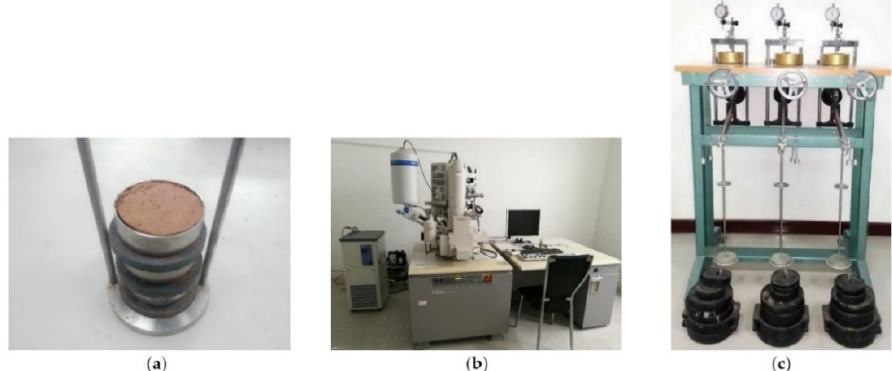
Figure 2. Samples and experimental apparatus: ( a ) prepared samples; ( b ) scanning electron microscope; ( c ) creep test of soil using the consolidation apparatus.